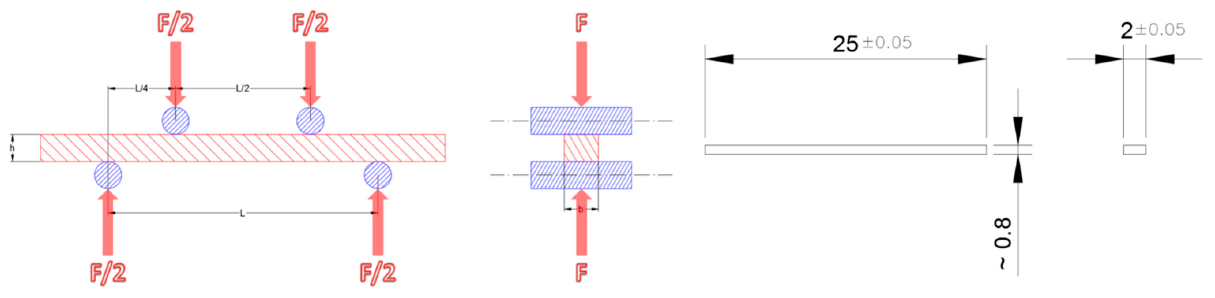
Figure 1. Symmetric four-point bending test configuration and test specimen geometry.